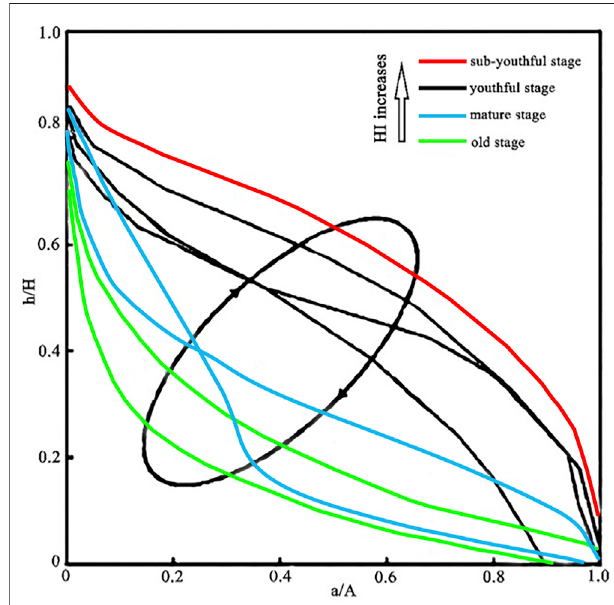
FIGURE2| Schematic diagram ofhypsometricintegral (HI) result: A, the totalareaofthewatershed;a,theareagreaterthentheithgradedelevation;H, the total range in elevation in the basin; h, the relative elevational difference betwen the ith classi fi cation elevation and the lowest point in the basin.